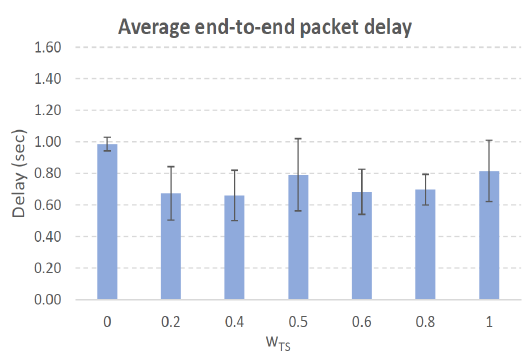
Figure 5. Average end-to-end packet delay. Scenario with very low social media interaction (TS nor- mal distribution with µ = 1 and σ = 1). Nodes’ density = 100 nodes/km 2 .